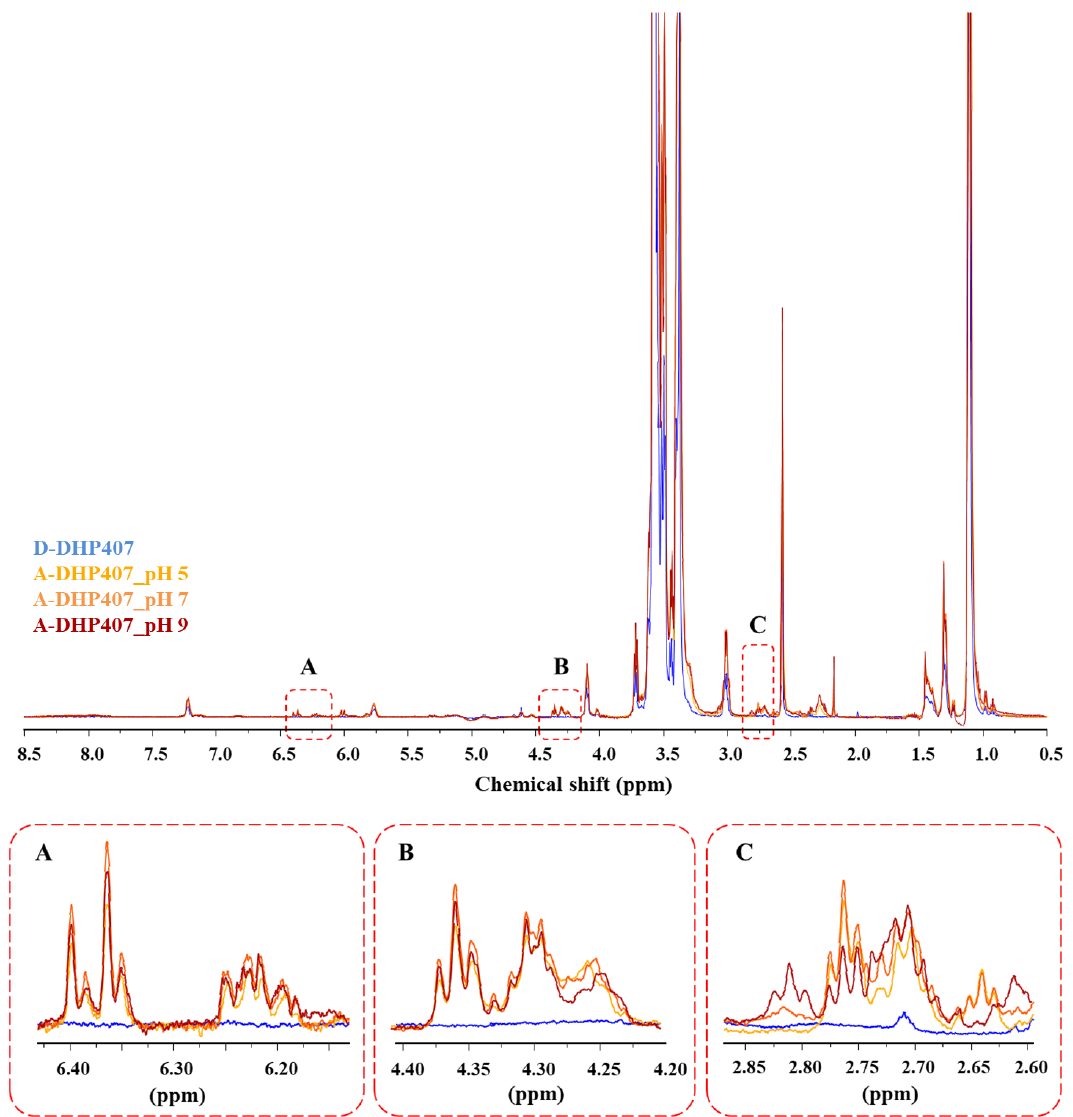
Figure 4. 1 H NMR spectra of D-DHP407 (blue, control condition) and A-DHP407_pHX (orange) samples. The increasing color intensity of the spectrum stands for the increasing reaction pH from 5 to 9. Magnified insert A highlights the signals attributed to the hydrogens involved in the double bonds of acrylate moieties in A-DHP407_pHX samples compared to D-DHP407 control PEU.